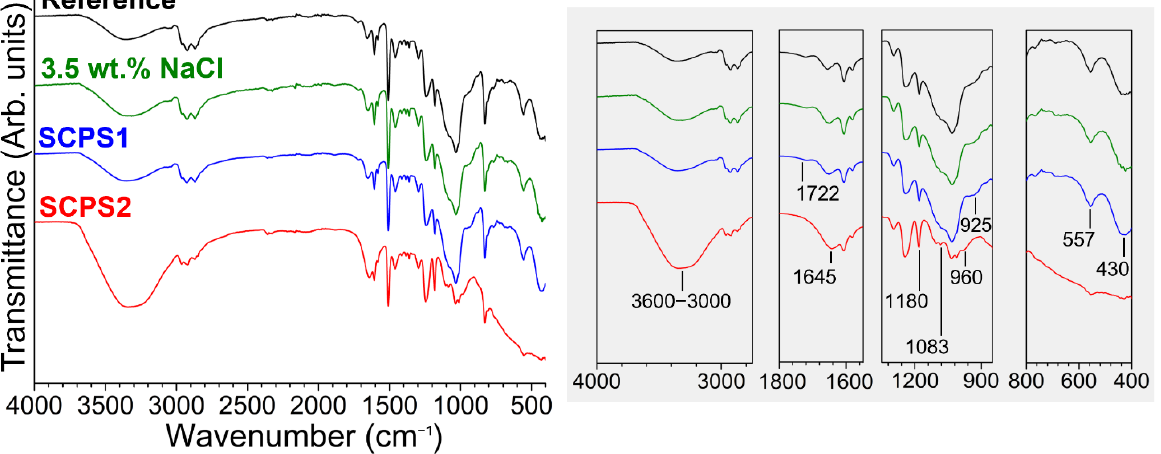
Figure 8. FTIR spectra of D0.4 freestanding films before and after 30 days of immersion in 3.5 wt.% NaCl, SCPS1, and SCPS2 solutions.